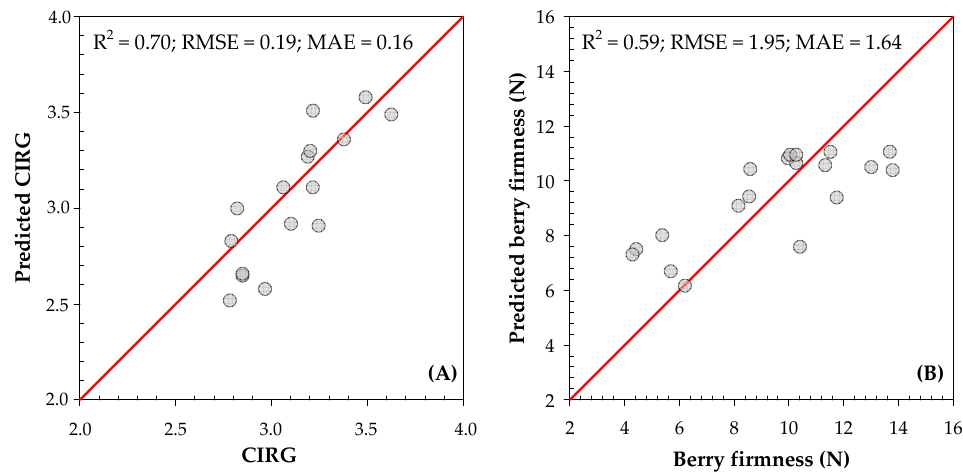
Figure 5. Predicted and observed color index of red grapes (CIRG) of clusters ( A ) and berry firmness ( B ) at harvest, for cv. Crimson seedless adult vines obtained through a Gaussian Process Regression with radial basis function kernel model, using as estimators the accumulated water stress integral post-veraison and fruit load, as clusters per vine and berries per cluster. The dataset for model ( A ) and ( B ) was n = 64 and n = 67, respectively.